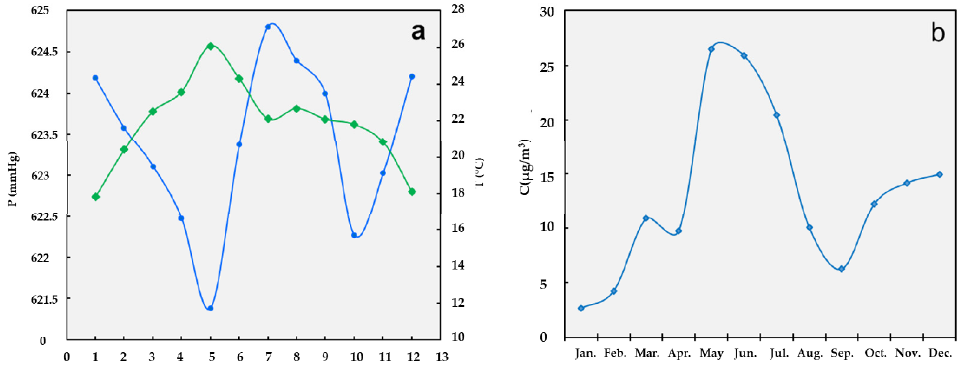
Figure 5. ( a ) 24 h average atmospheric pressure and room temperature and ( b ) 24 h SO 2 average concentration. Source: own elaboration.